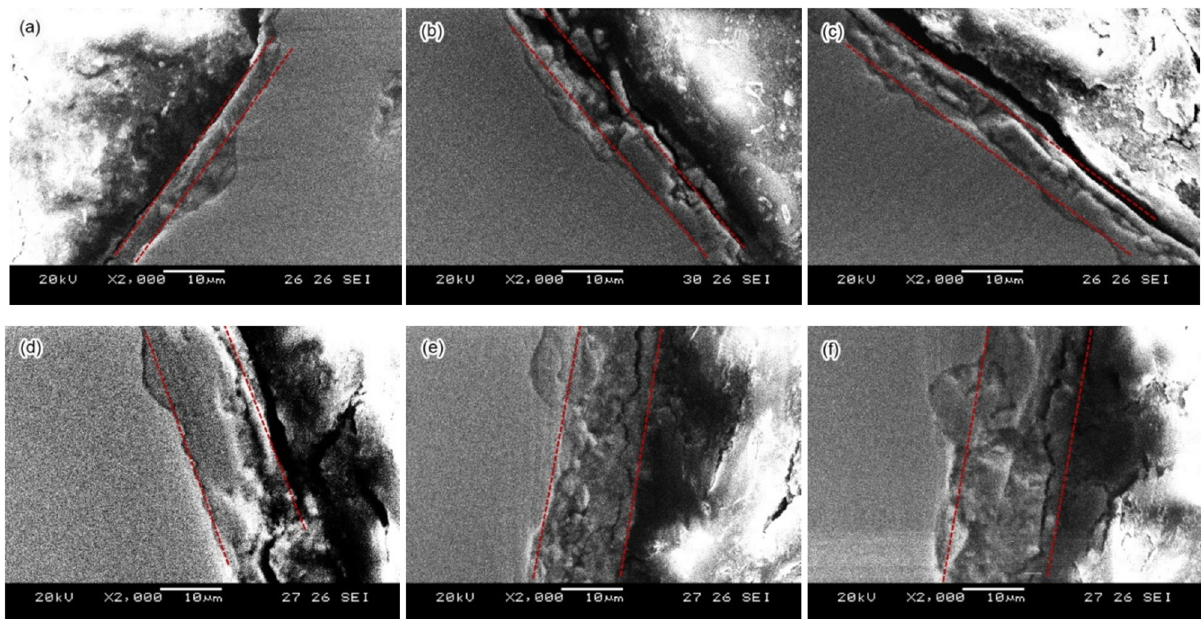
Figure 4: Oxide - scale morphologies of the steel sample at di ff erent temperatures for 30 min: ( a ) 850°C, ( b ) 900°C, ( c ) 950°C, ( d ) 1,000°C, ( e ) 1,050°C, and ( f ) 1,100°C.